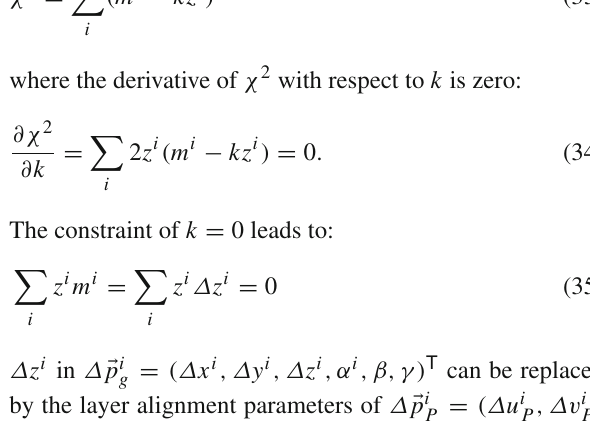
tracks with given momenta in the magnetic field is equiva- lent to straight tracks. Any linear coordinate transformation will conserve the linearity of a straight track and hence not be sensedbythetrackalignmentprocedure.Conversely,without specific constraints, an unstable system of the alignment due to χ 2 invariance could introduce this kind of transformation, manifested as an extra detector displacement or